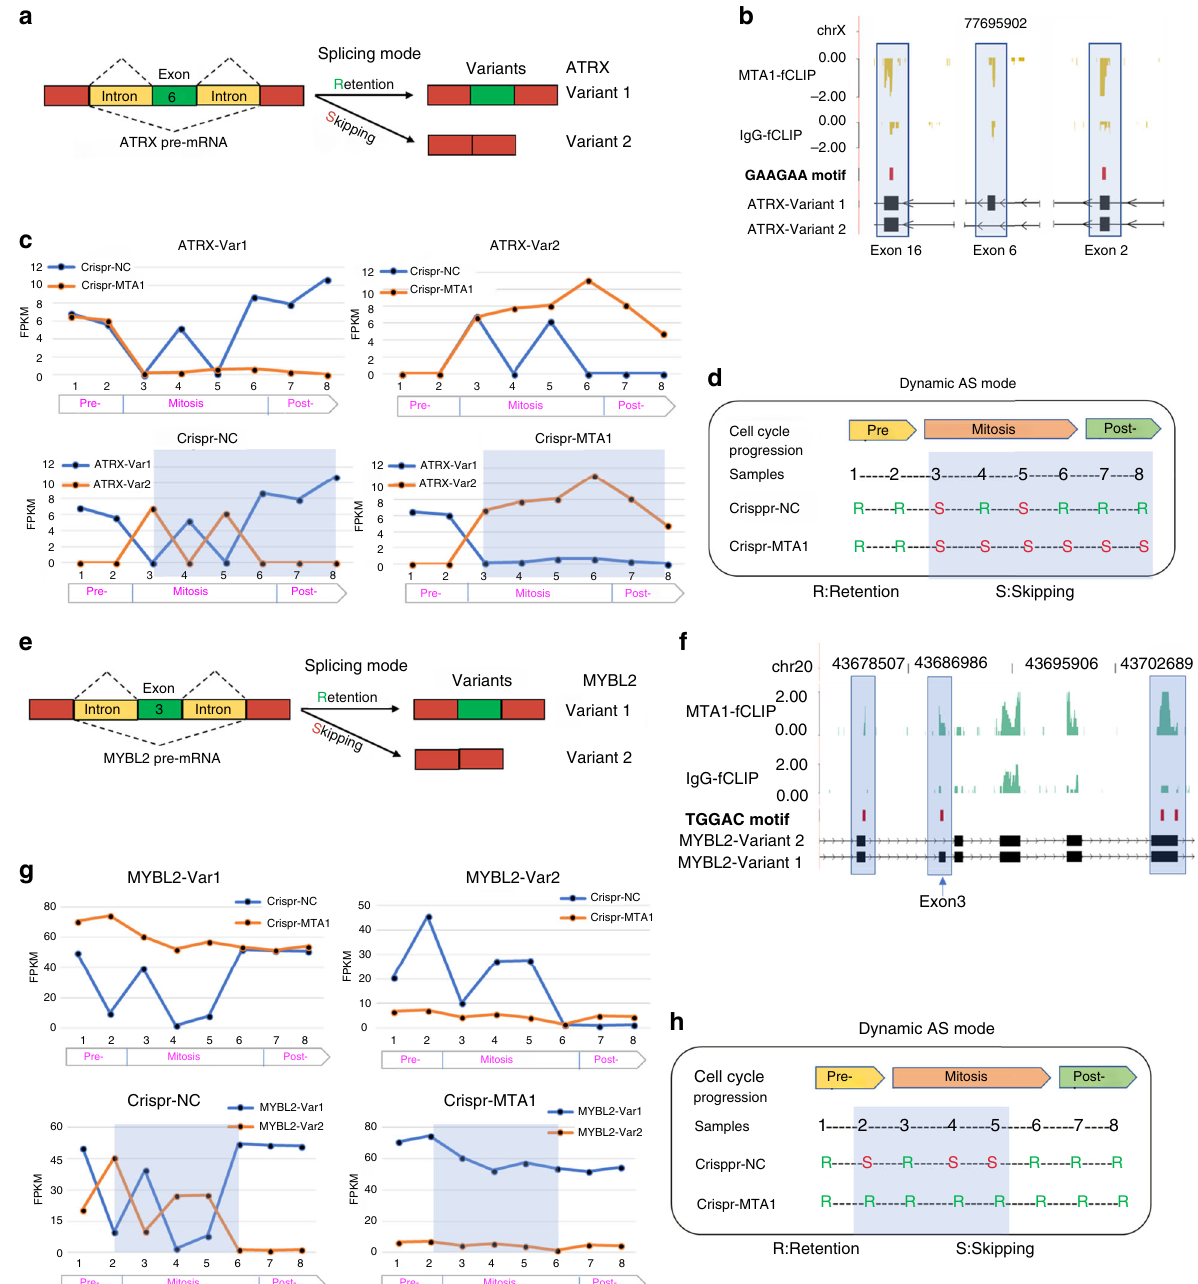
Fig. 6 MTA1 drives mitosis-speci fi c AS switch of mitosis regulators. a The alternative splicing mode of the ATRX pre-mRNA. Variant 1 was produced with exon 6 retention, while variant 2 was with exon 6 skipping. b fCLIP-seq read density plot showing the speci fi c binding of MTA1 to exon 6 and the GAAGAA motifs. c MTA1 regulates both the AS pattern and the AS dynamics of ATRX during mitosis. Var1, variant 1. Var2, variant 2. d The dynamic changes in the AS mode of ATRX with the cell cycle progression. R: exon 6 retention; S: exon 6 skipping. e The alternative splicing mode of the MYBL2 pre-mRNA. Variant 1 was produced with exon 3 retention, while variant 2 was with exon 3 skipping. f fCLIP-seq read density plot showing the speci fi c binding of MTA1 to exon 3 and the TGGAC motifs. g MTA1 regulates both the AS pattern and the AS dynamics of MYBL2 during mitosis. h The dynamic changes in the AS mode of MYBL2 with the cell cycle progression. R: exon 6 retention; S: exon 6 with 80 µl of protein A/G beads (Santa Cruz) for 5h at 4°C. The immunopreci- in a vacuum centrifuge. The in-gel proteins were reduced with dithiothreitol pitates were washed 6 times with NP-40 buffer and were collected after cen- (10 mM DTT/100mM NH 4 HCO 3 ) for 30 min at 56 °C and were then alkylated trifugation at 3500 g for 5min. Subsequently, the beads were boiled in SDS loading with iodoacetamide (200mM IAA/100mM NH 4 HCO 3 ) in the dark at room buffer for 10 min, and the supernatant was concentrated with Amicon Ultra 0.5ml temperature for 30 min. The gel pieces were brie fl y rinsed with 100 mM NH 4 HCO 3 10K centrifugal fi lter (Millipore) before SDS-PAGE separation. The gels were and ACN, respectively. The gel pieces were digested overnight in 12.5ng/ μ l trypsin stained with Coomassie brilliant blue (Invitrogen) after electrophoresis. Each gel in 25 mM NH 4 HCO 3 . The peptides were extracted three times with 60% ACN/ lane was separated into 5 sections, which were processed to mass spectrometry 0.1% TFA. The extracts were pooled and dried completely by a vacuum centrifuge. identi fi cation independently at Shanghai Applied Protein Technology Co., Ltd. The The EttanTM MDLC system (GE Healthcare) was applied for the desalting and gel pieces were destained with 30% ACN/100 mM NH 4 HCO 3 . The gels were dried separation of the tryptic peptides mixtures. In this system, the samples were